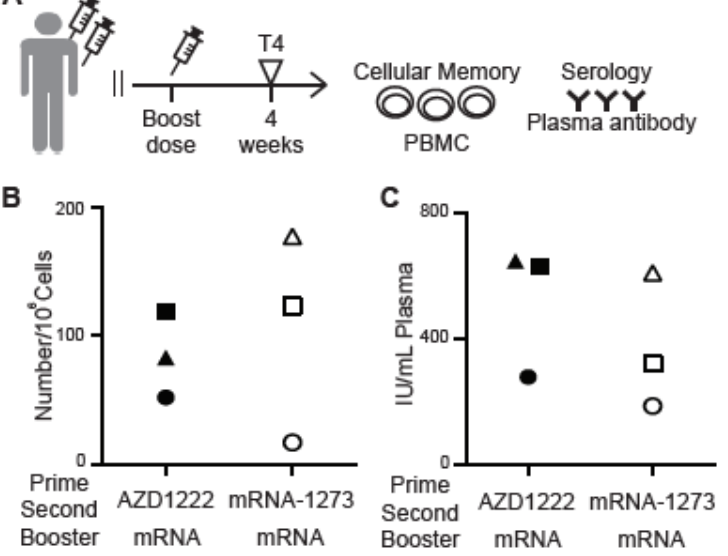
Figure 6. Omicron spike-RBD-specific memory B cells detected by the MiSelect R II system after boost vaccination. ( A ) Blood was collected 4 weeks after a 3rd vaccine shot (T4). ( B ) CD19+, CD27+, IgG+, wildtype or Omicron spike-RBD+, CD3- specific MBCs in PBMC samples from mRNA boost vaccination (n = 6). ( C ) Concentration of neutralizing anti-wildtype-RBD or anti-Omicron-RBD IgG antibodies in plasma sample from mRNA boost vaccination (n = 6).